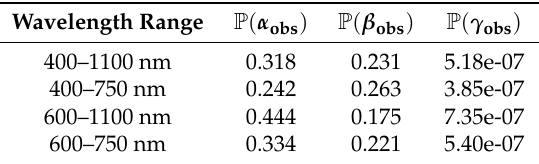
Table 1. Dependence of the probabilities of our observed quantities on the upper and lower limits of the photosynthetic